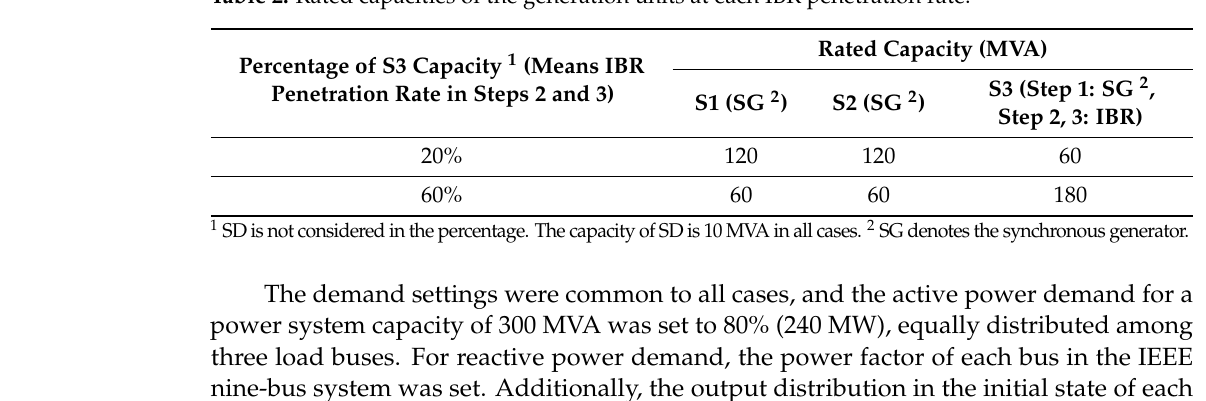
Table 2. Rated capacities of the generation units at each IBR penetration